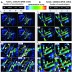
Coevolutionary connection and evolutionary conservation are projected onto the 3D structures of proteins from two different protein families.Panel
A1 provides an example of higher coevolutionary connections (average >20) with respect to an overall lower evolutionary conservation (average AL2CO score: 0.65) status projected on the 3D structure of a representative protein (PDB code: 1DJ0) from the pseudouridine synthase domain family (CDD code: CD01291). Panel
B1 represents a case [representative protein (PDB code: 1SRO; CDD code: CD00164) from the ribosomal protein S1 domain] where lower coevolutionary connections (average <10), with respect to overall higher evolutionary conservation (average AL2CO score: 1.63) status are observed. Lower panels (
A2 and
B2) show examples from the same families (zoomed image) of higher coevolutionary connections for sites that have relatively higher evolutionary conservation.